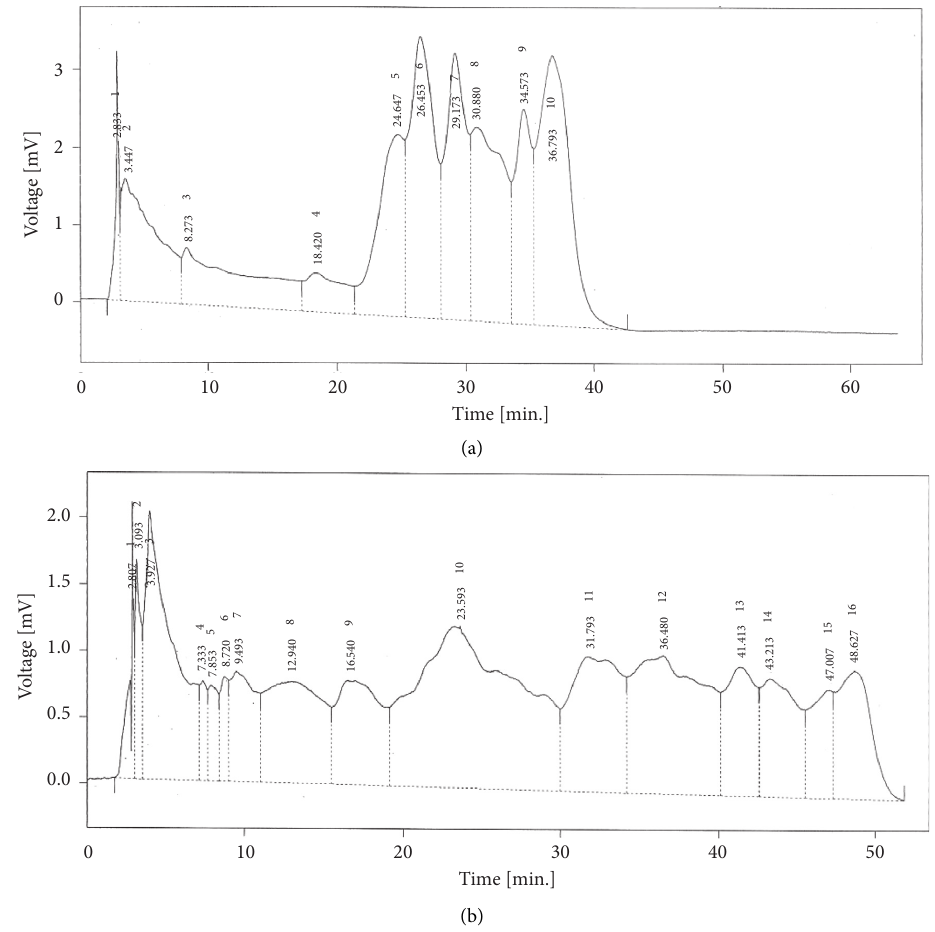
Figure 4: HPLC chromatograms of (M) charantia (L) fruit for phenolic profile. (a) Control, (b) zinc sulfate